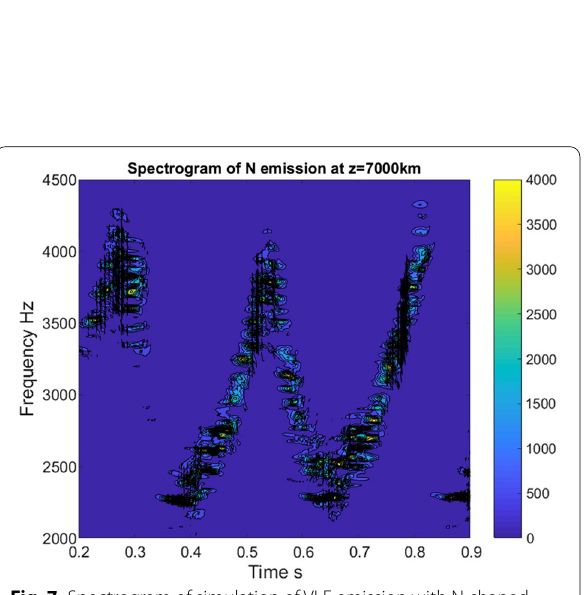
Fig. 7 Spectrogram of simulation of VLF emission with N-shaped frequency–time profile. The equatorial linear growth rate is increased to a high-level 380db/s. The triggering wavefield is a strong key down doublet of amplitude 80pT, frequencies 2140 and 2340 Hz